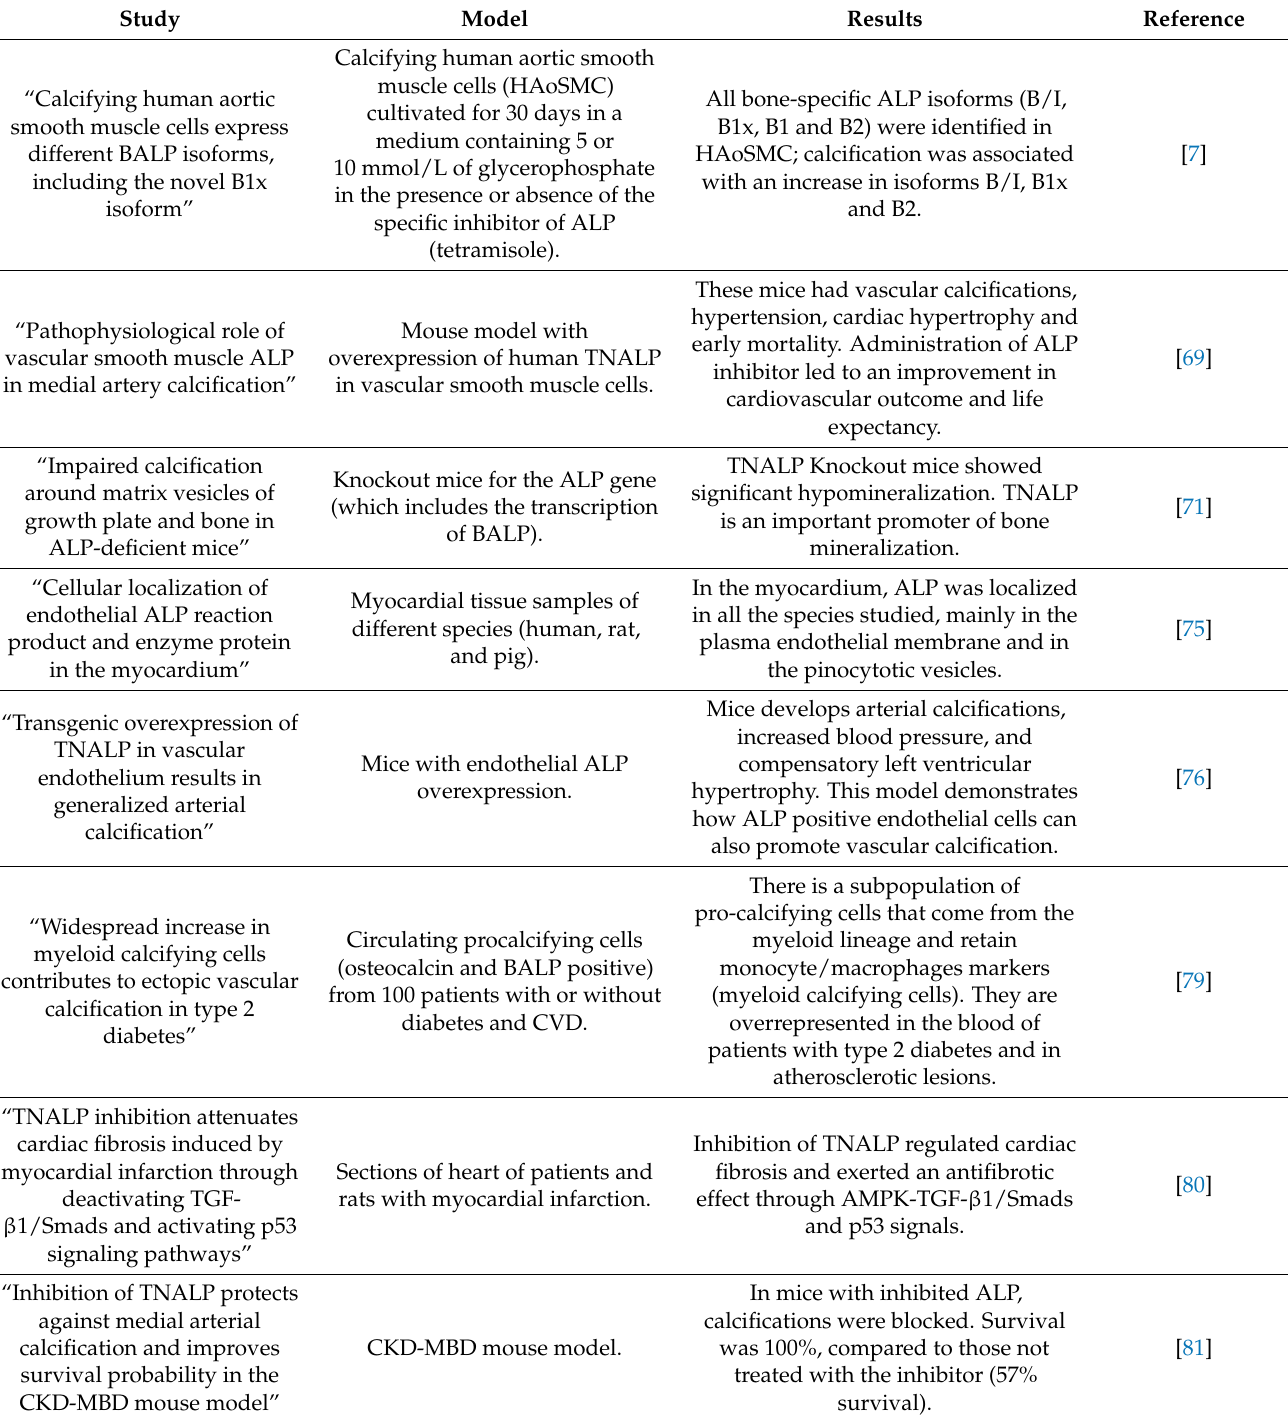
Table 1. The role of ALP in vascular calcifications: experimental